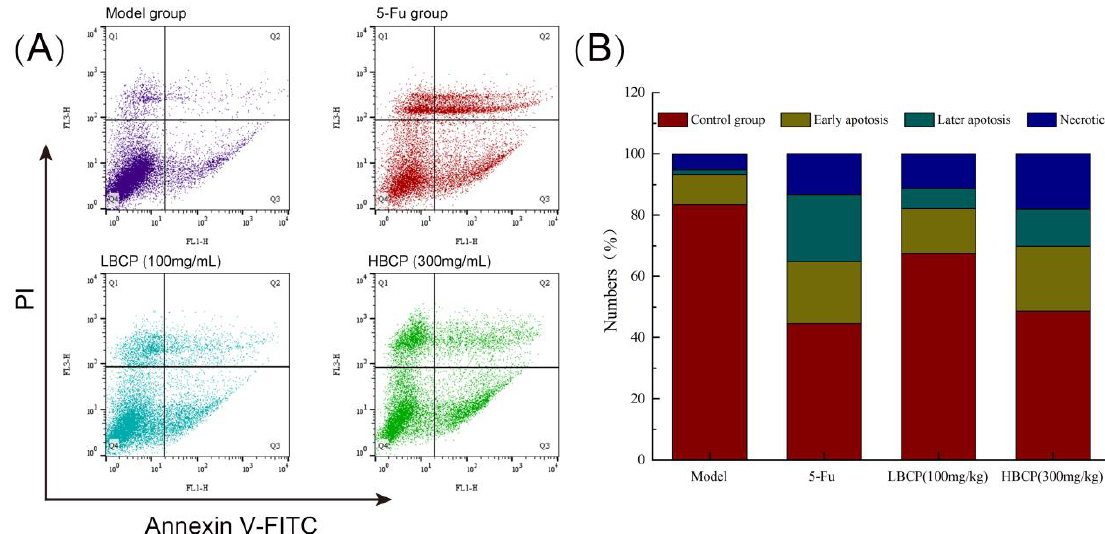
Figure 12. ( A ) Apoptosis of H22 solid tumor cells after FITC-AnnexinV and PI double staining in different groups; ( B ) Bar chart of apoptosis percentage.